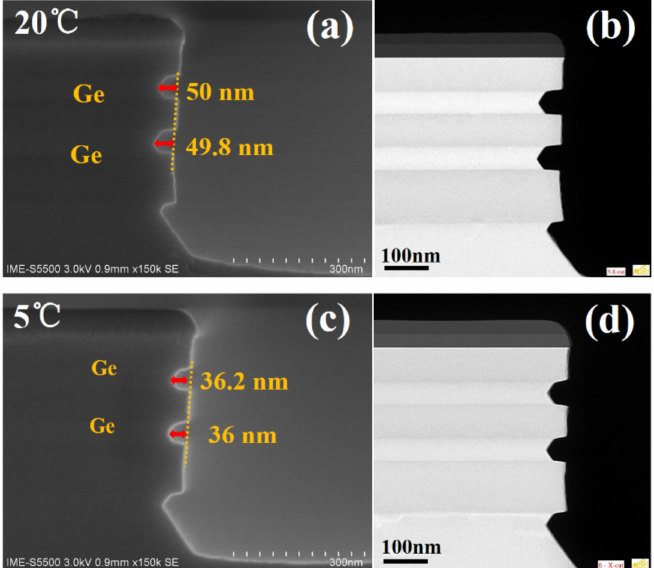
Figure 5. The SEM and TEM images of etching profile of p + -Ge 0.8 Si 0.2 /Ge multilayers after ALE at ( a , b ) 15 cycles (temperature of HNO 3 = 20 ◦ C); ( c , d ) 20 cycles (temperature of HNO 3 = 5 ◦ C). The oxidation time t ox = 30 s.